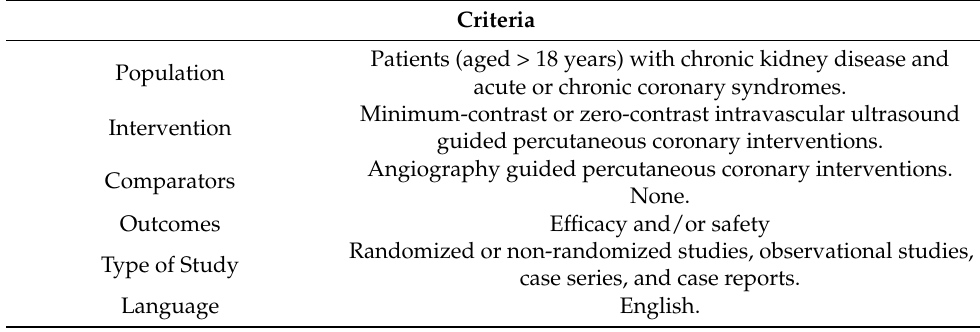
Table 1. Inclusion criteria for selected studies according to the PICOS statement. Criteria Patients (aged > 18 years) with chronic kidney disease and Population acute or chronic coronary syndromes. Minimum-contrast or zero-contrast intravascular ultrasound Intervention guided percutaneous coronary interventions. Angiography guided percutaneous coronary interventions. Comparators None. Outcomes Efficacy and/or safety Randomized or non-randomized studies, observational studies, Type of Study case series, and case reports. Language